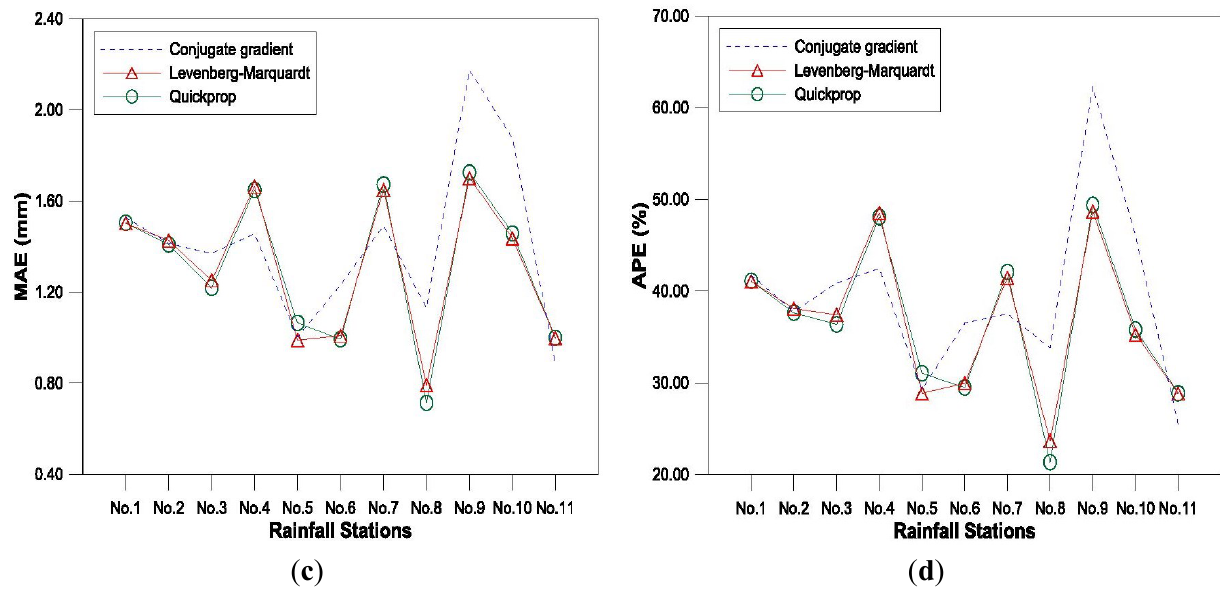
Figure 8. Influence of individual rainfall stations for three training algorithms of KSOFM2 (test period). ( a ) NS; ( b ) MAF; ( c ) RMSE; ( d )